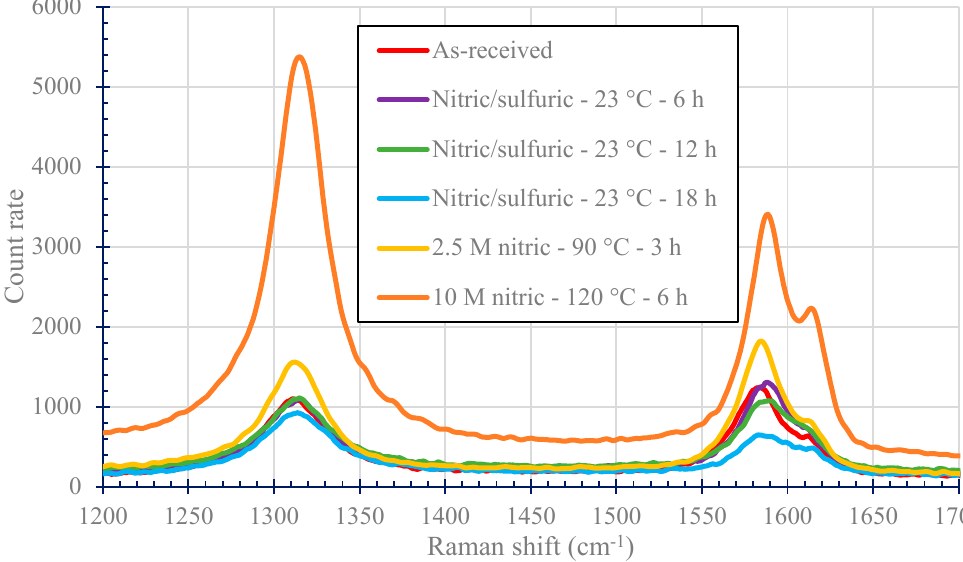
Figure 7. Representative Raman curves of as-received and acid-treated carbon nanotubes. Table 5. Raman results for as-received and acid-treated carbon nanotubes.